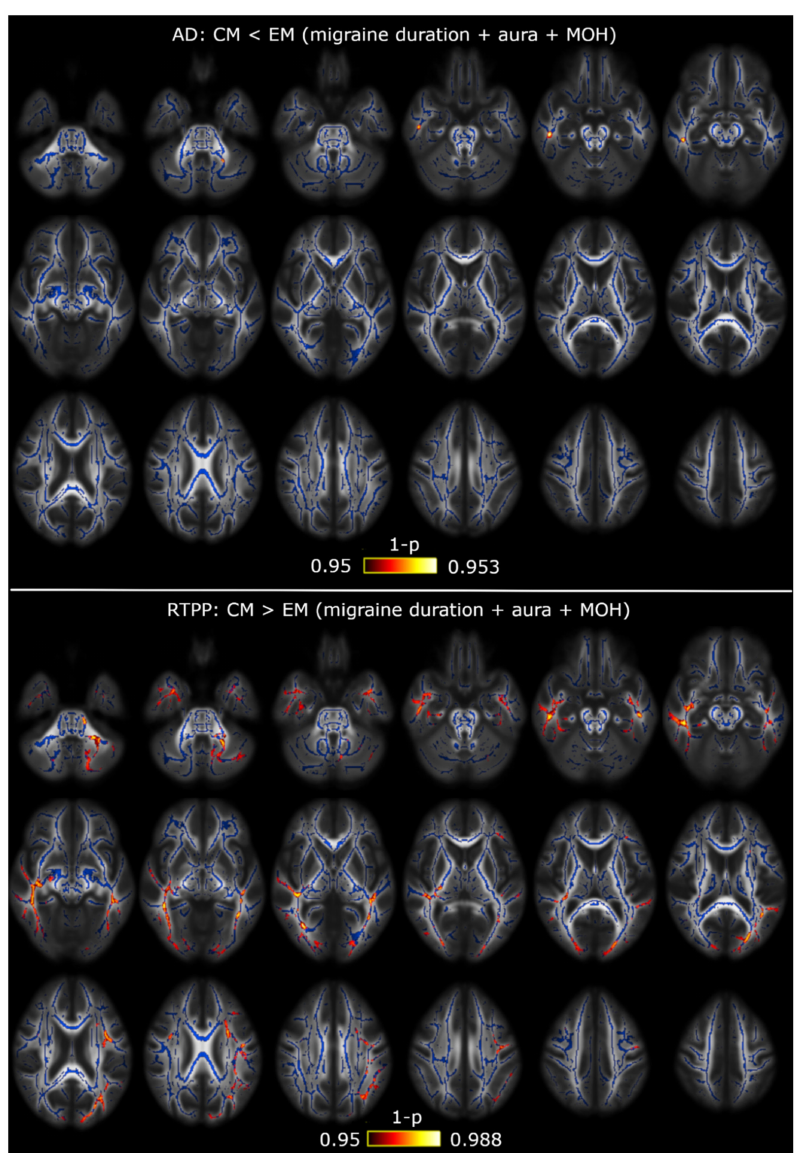
Figure A3. AD and RTPP alterations between CM and EM including the duration of the migraine, presence of aura and medication overuse headache as covariates. TBSS showed decreased AD and increased RTPP values in CM with respect to EM. The white matter skeleton is shown in blue, and voxels with the lowest p -values in red-yellow. The color bar shows the 1- p -values (FWE-corrected). MOH = medication overuse